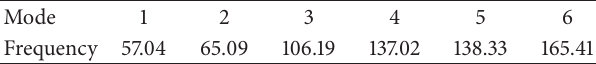
Figure 14: Curves of experimentally measured and simulated acceleration of the slider under a rotational speed of the servomotor of 600 r/min.